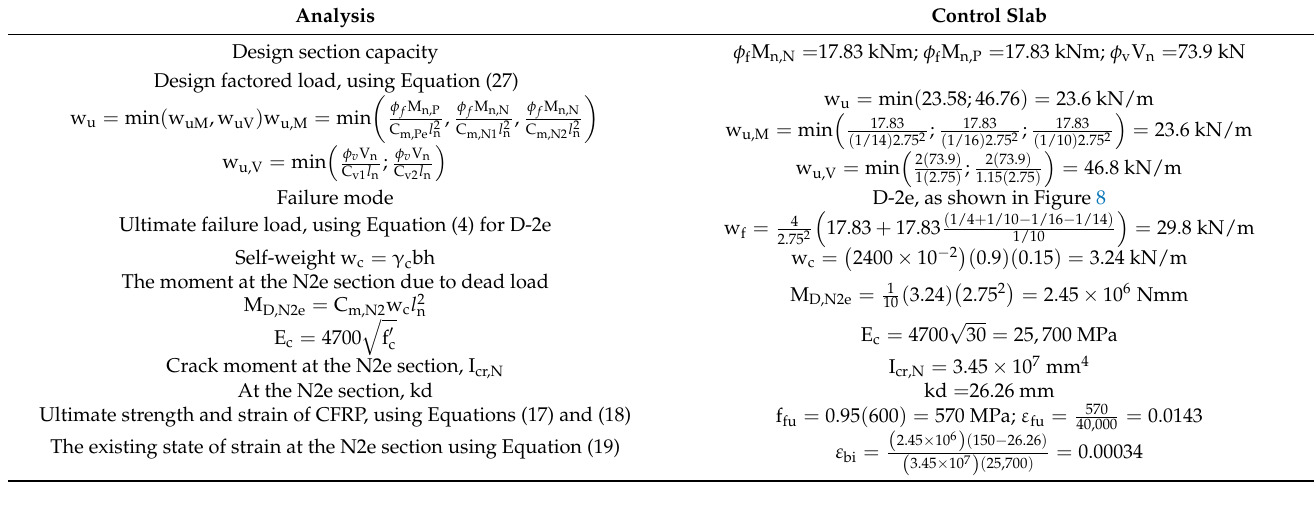
Table 4. The preliminary calculation for the control slab and retrofit system.